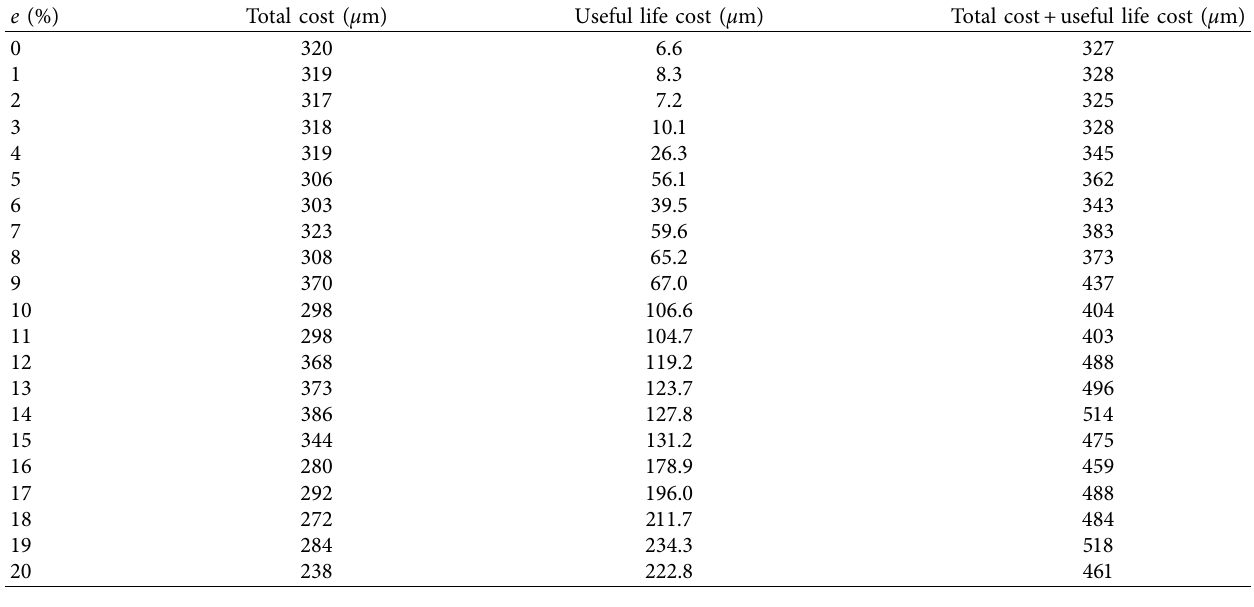
Table 8: Variation of useful life costs and total costs with respect to tolerance levels.